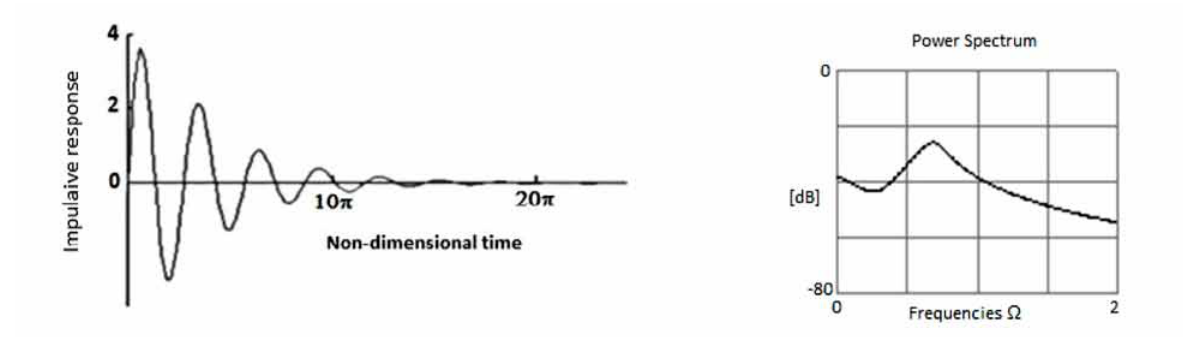
(b) Impulsive response by the inverse Fourier transform Fig. 2. Comparison of methods